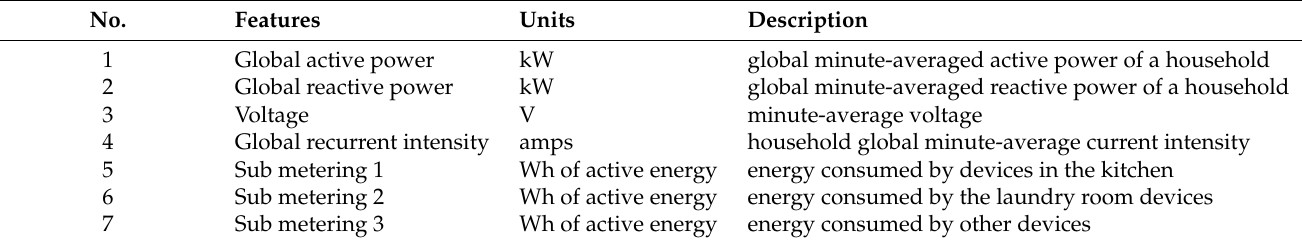
Table 1. Description of the dataset features.